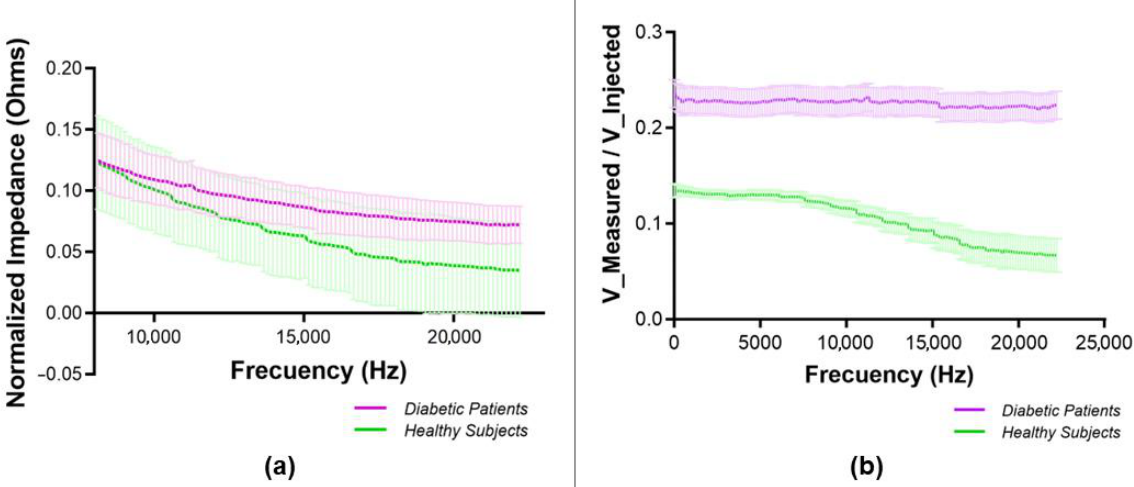
Figure 7. ( a ) Comparison of normalized impedance in diabetic patients and healthy subjects. Dotted lines indicate the standard error of the mean (SEM). ( b ) Comparison of the ratio of measured voltage over injected voltage in diabetic patients and healthy subjects. Behavior of the ratio of the measured voltage to the injected voltage in the two study groups: diabetic patients and healthy subjects. The dotted lines are the standard deviation (SD). SEM is not shown as it appears very close to the mean values.